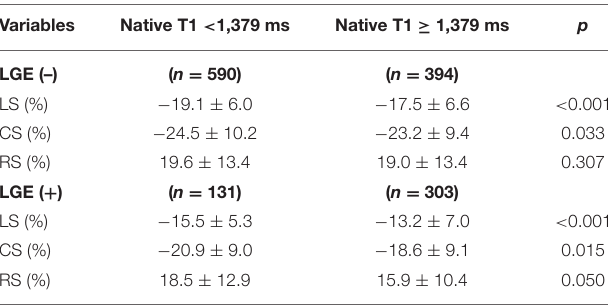
TABLE 4 | Comparison of strain between segments with high and low native T1 stratified by presence or absence of segmental